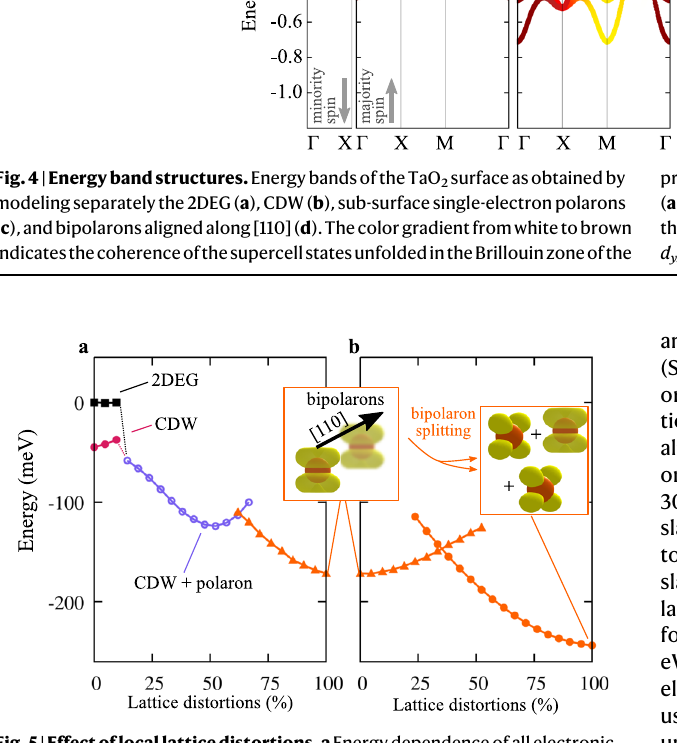
Fig.5|Effectoflocallatticedistortions.a Energydependenceofallelectronic statesonthelatticedistortions;theionsareprogressivelymoved(byusingalinear interpolation,seeMethodsSection)fromtheFE-distorted1×1lattice(0%)tothe structuredistortedbybipolaronsalignedalong[110](100%);atransientphaseis observed,showingsingle-electronpolaronscoexistingwiththeCDW(withalocal energyminimumaround50%). b Bipolaronsplitting,i.e.,transitionfrom bipolaronsalignedalong[110](0%)toamixedcon fi